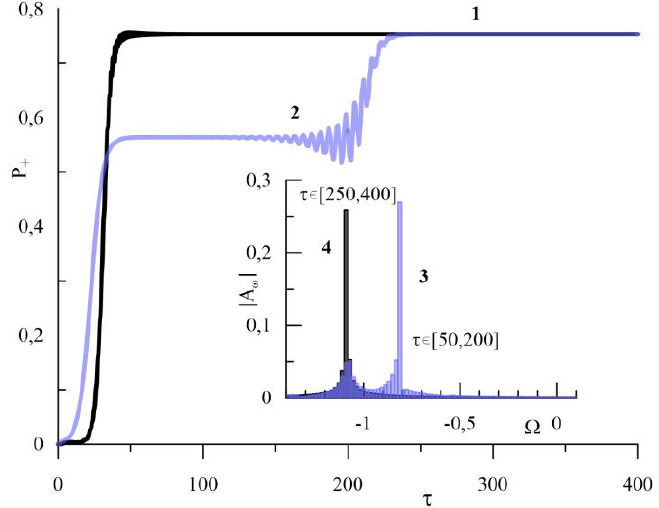
Fig. 7. Onset of the stationary oscillation regime. Temporal dependence of the energy flow from the right edge of the laser is shown in cases of the symmetric (1) and anti-symmetric (2) initial conditions. In the insert, the field spectra at the initial stage are shown in case of anti-symmetric initial conditions (3) and settled single-mode oscillation (4). 5